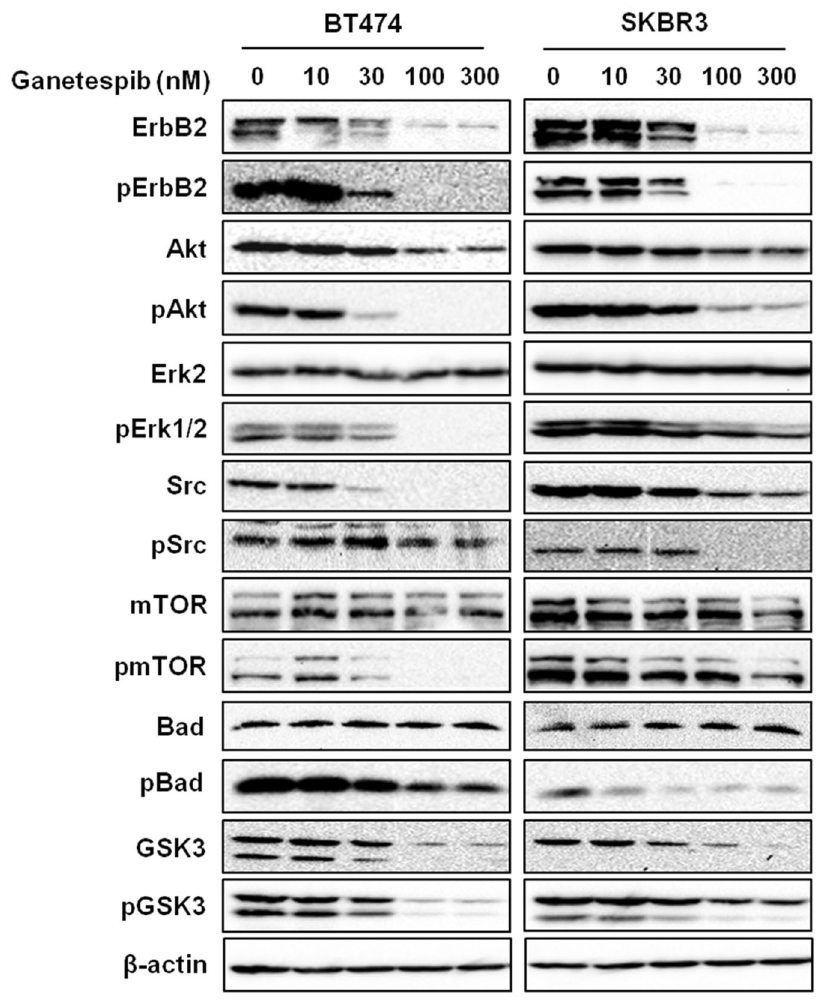
Figure 4. Ganetespib inhibits RTK signaling in ErbB2 + breast cancer cells. BT474 and SKBR3 cells were treated with ganetespib (0, 10, 30, 100, or 300 nM) for 16 hours, followed by Western blot analysis (cropped images) of the expression and activation/phosphorylation of the indicated markers involved in RTK